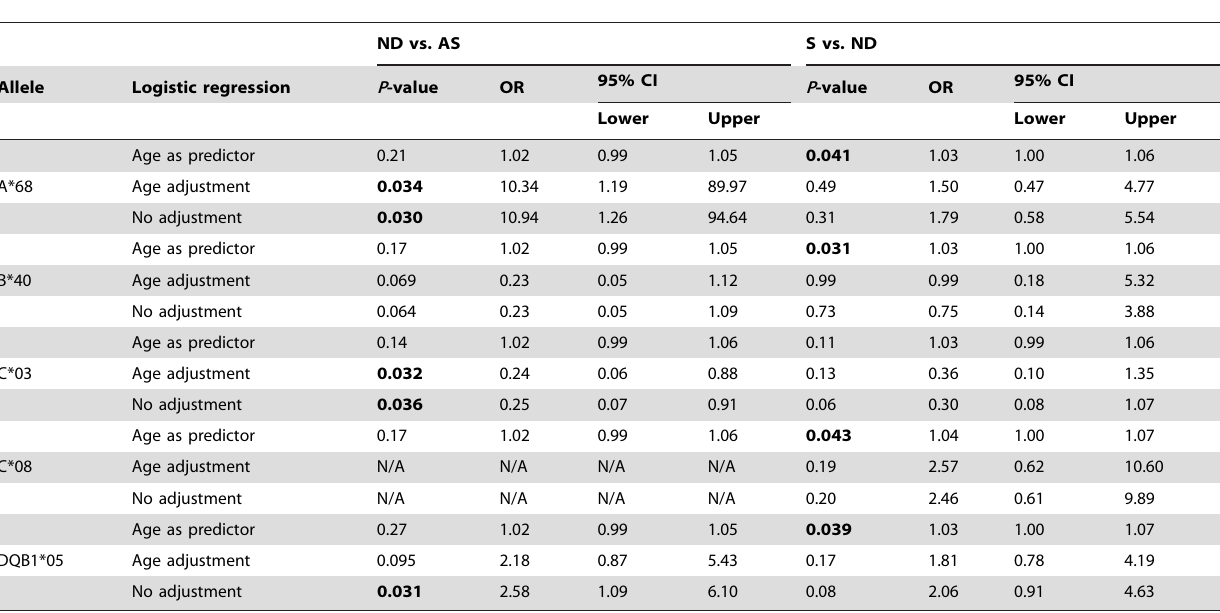
Table 4. Combined effect of age and allele phenotype on disease outcome using logistic regression analysis comparing asymptomatic (AS), symptomatic (S), and neuroinvasive disease (ND) outcome groups.